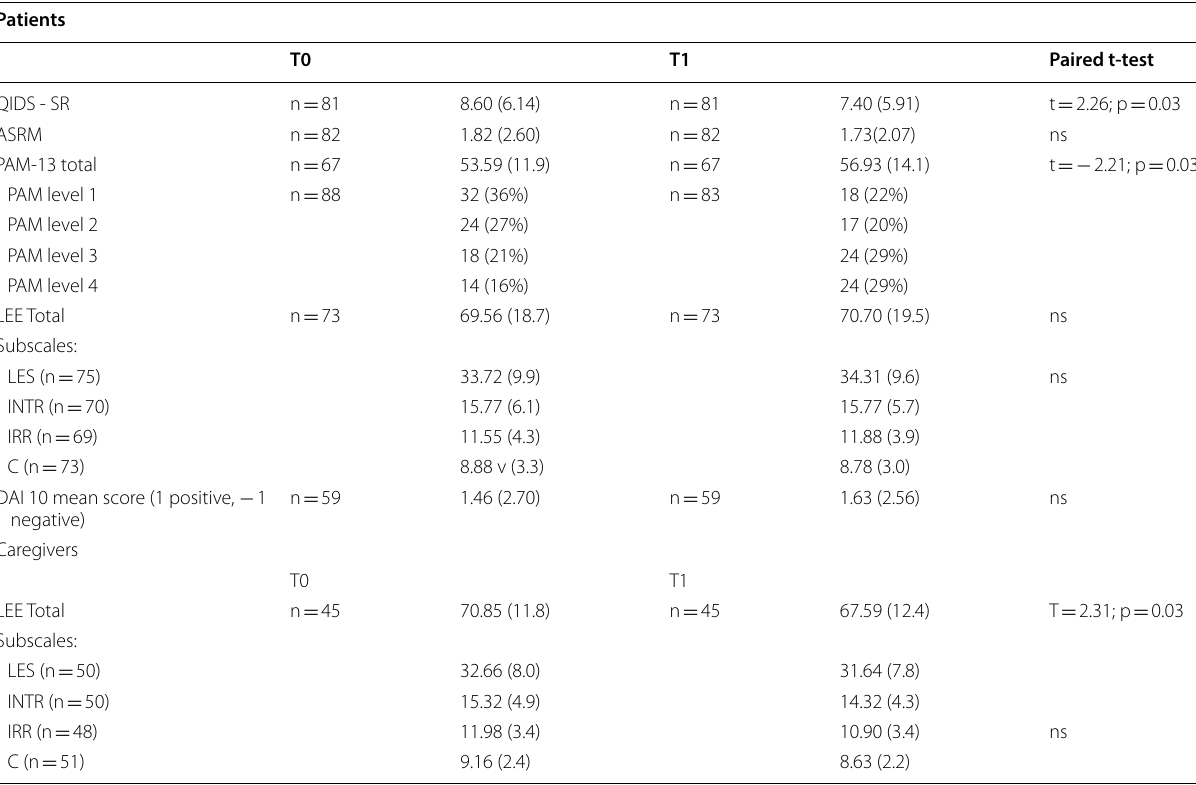
QIDS- SR, self-rated Quick Inventory of Depressive Symptomatology; ASRM, Altman Self-Rating Mania Scale; PAM-13, short form of the Patient Activation Measure; DAI 10, Drug Attitude Inventory; LEE, Level of Expressed Emotion (LES, lack of emotional support; INTR, intrusiveness; IRR, irritability; C, criticism)